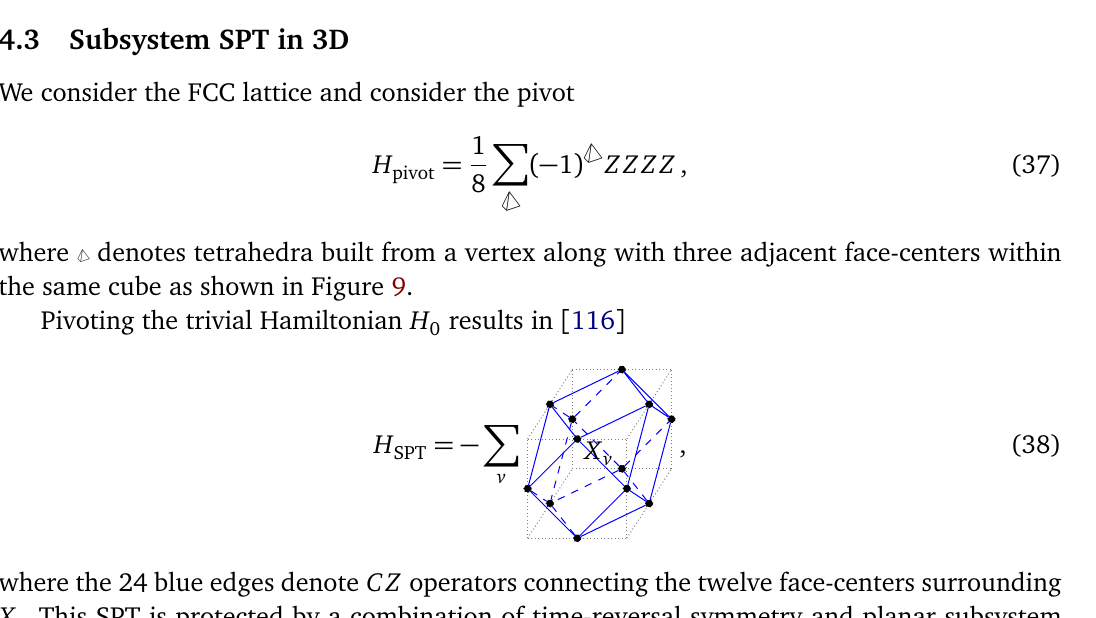
Figure 9: The tetrahedral Ising interaction on the FCC lattice is constructed for a vertex along with three adjacent face-centers within the same cube. The pivot is constructed from an alternating sum of such